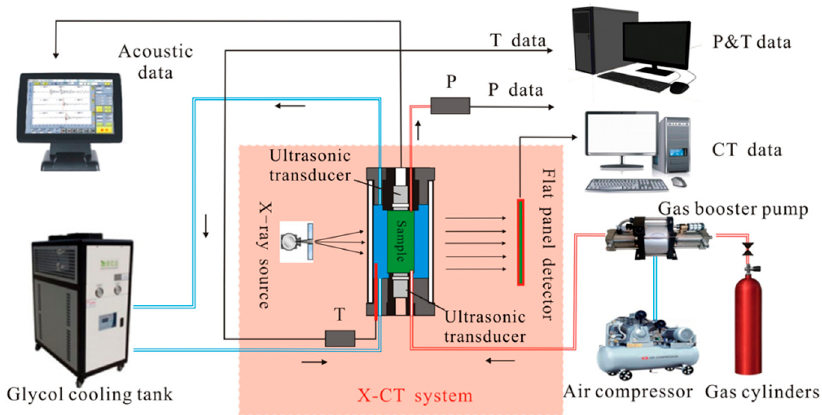
Figure 1. Schematic configuration of the ultrasonic–CT combined detection system for hydrate.